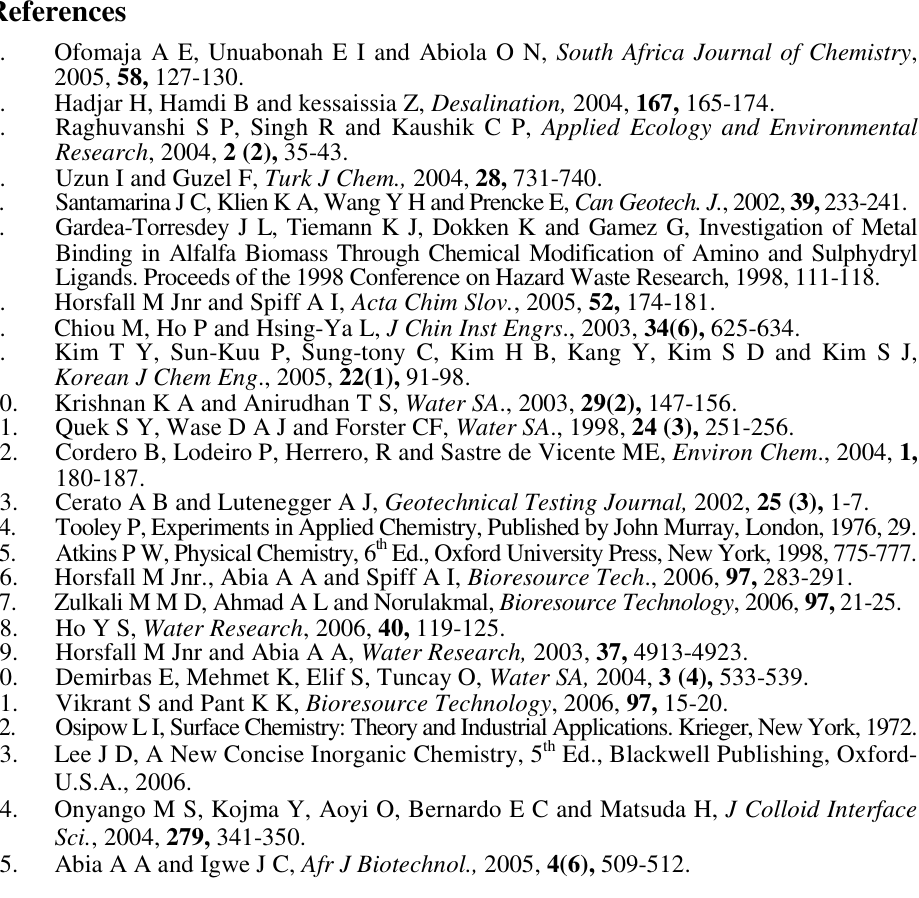
Figure 9. Plot of maximum adsorption capacity at different ionic charge ionic